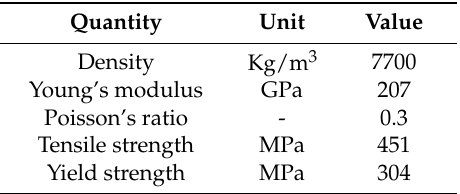
Table 4. Material properties of rotor core.